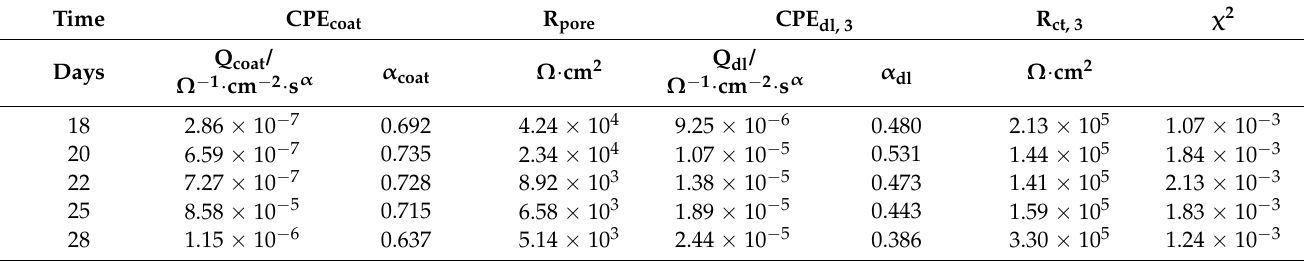
Table 6. Fitted values of EEC components for a coating prepared from the formula Zn–80%-PC, Stage 3.